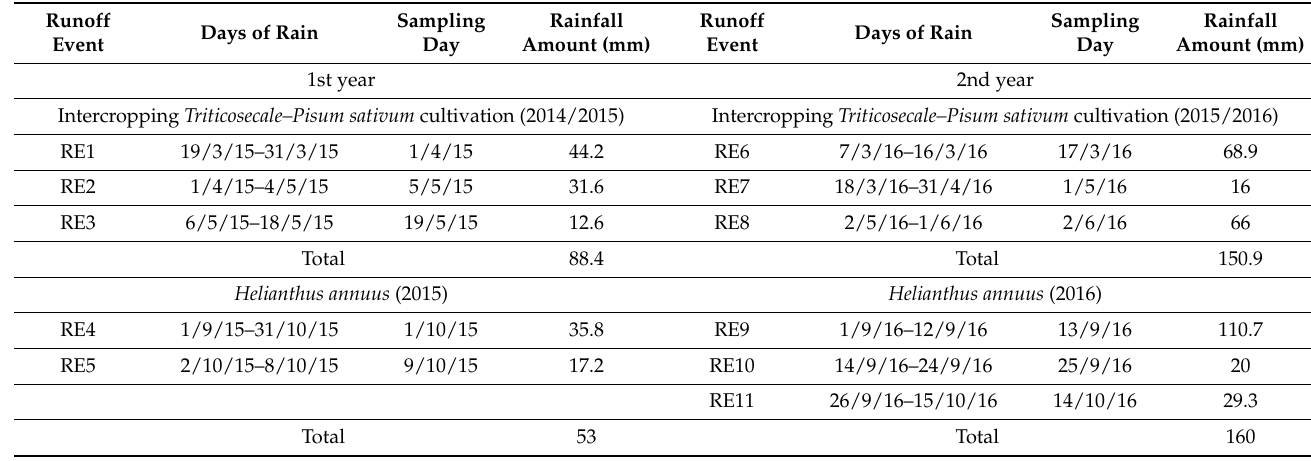
Table 2. Characteristics of the rainfall events generating runoff volumes.